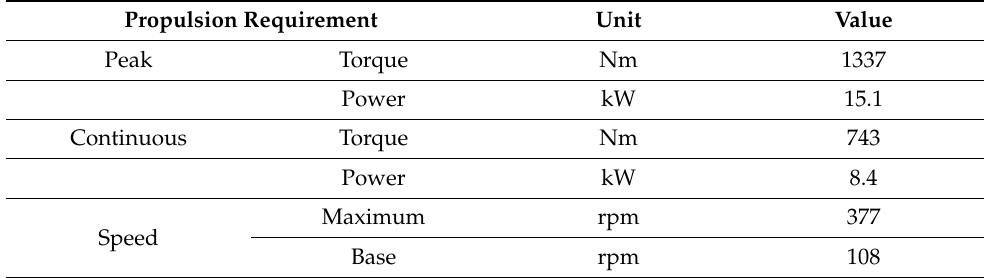
Table 4. Unit propulsion system requirements.